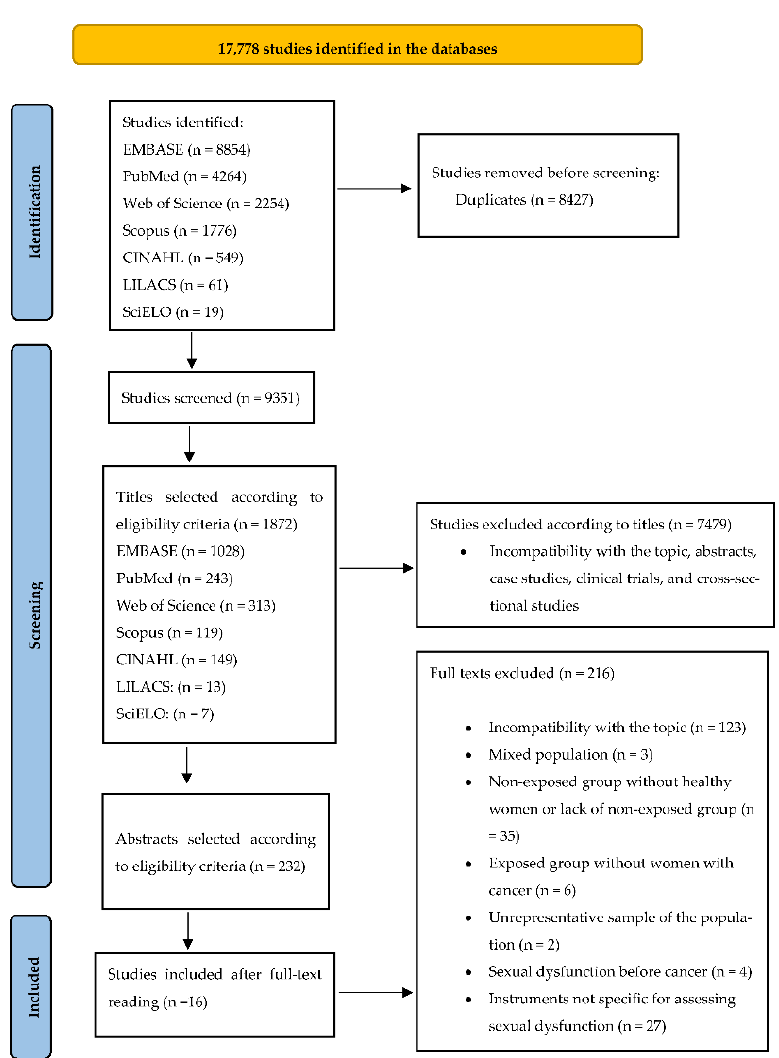
Figure 1. PRISMA 2020 flow diagram.